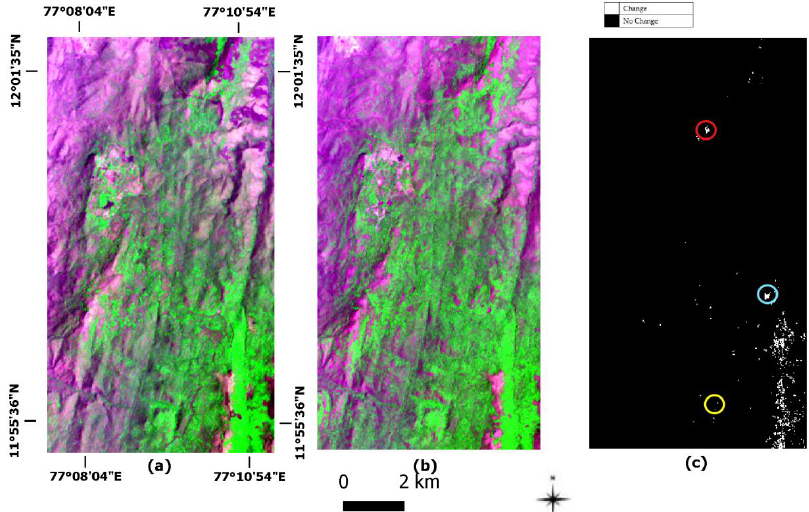
Figure 9 Figure 9. Experiment 1—DIFF_NDVI_HR, Indian site: ( a ) Landsat 5 TM image, 16 March 1997, RGB: Red–Nir–Blue (T 1 ); ( b ) Landsat 8 OLI image, 20 March 2016, RGB: Red–Nir–Blue (T 2 ); and ( c ) change map. Attention areas: red, blue and yellow